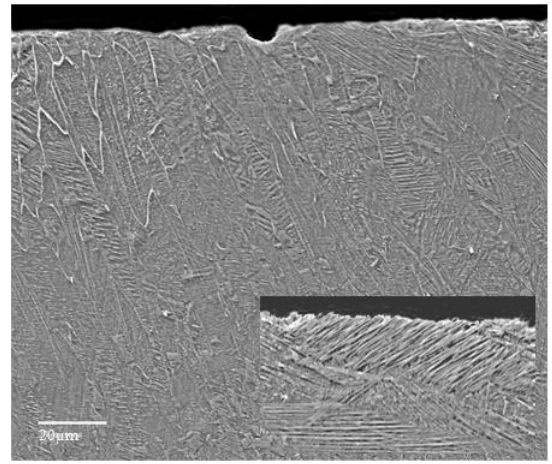
Figure 10. Cross-sectional details of the cavitation erosion effects. The inset shows the acicular substructure.